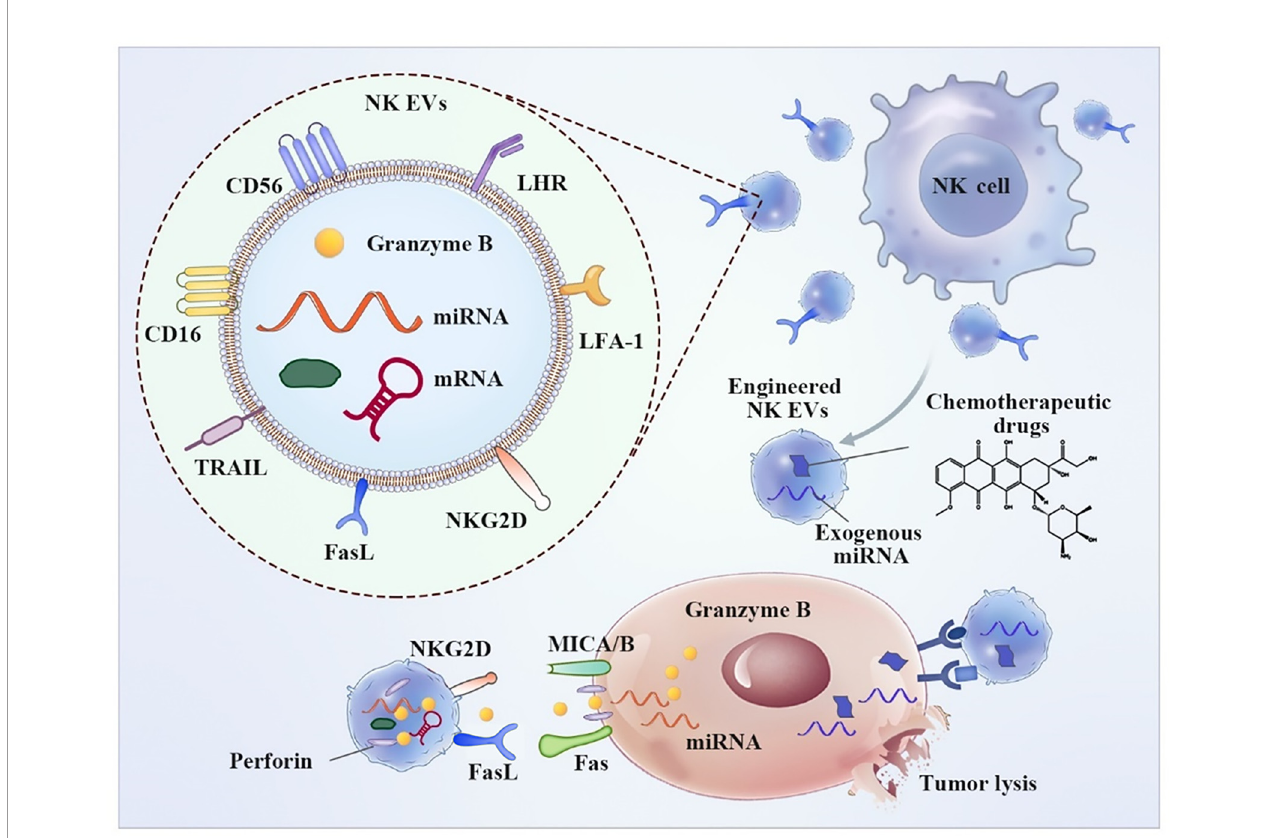
FIGURE 1 | Typical characteristics and anti-tumor application of NK-derived EVs. NK EVs binds tumor cells through NKG2D-MICA/B and exhibit cytotoxic effect resulting from a cargo of released cytotoxic proteins, including perforin, granzymes and small antimicrobial peptides, resulting tumor cell apoptosis. Additionally, Engineered NK EVs-coated nanoparticle was employed for chemotherapeutic drug